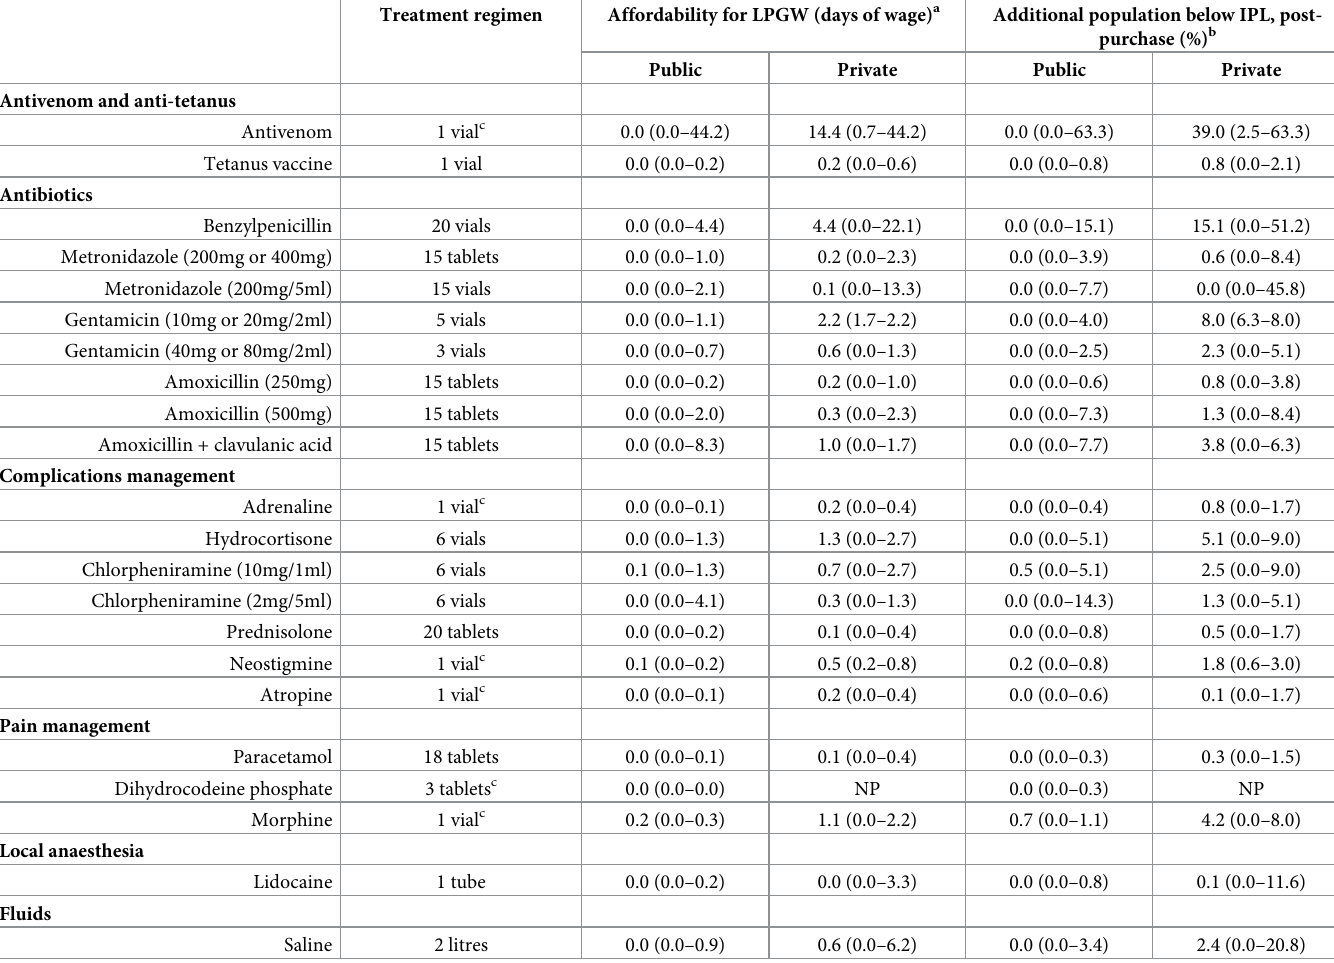
Table 5. Affordability of snakebite commodities, using the wage of an LPGW and the impoverishment approach, per